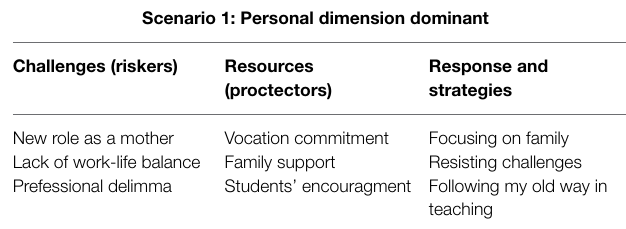
Resislience downward: Homeastasis-breaking and changes-resisting Scenario 1: Personal dimension dominant Challenges